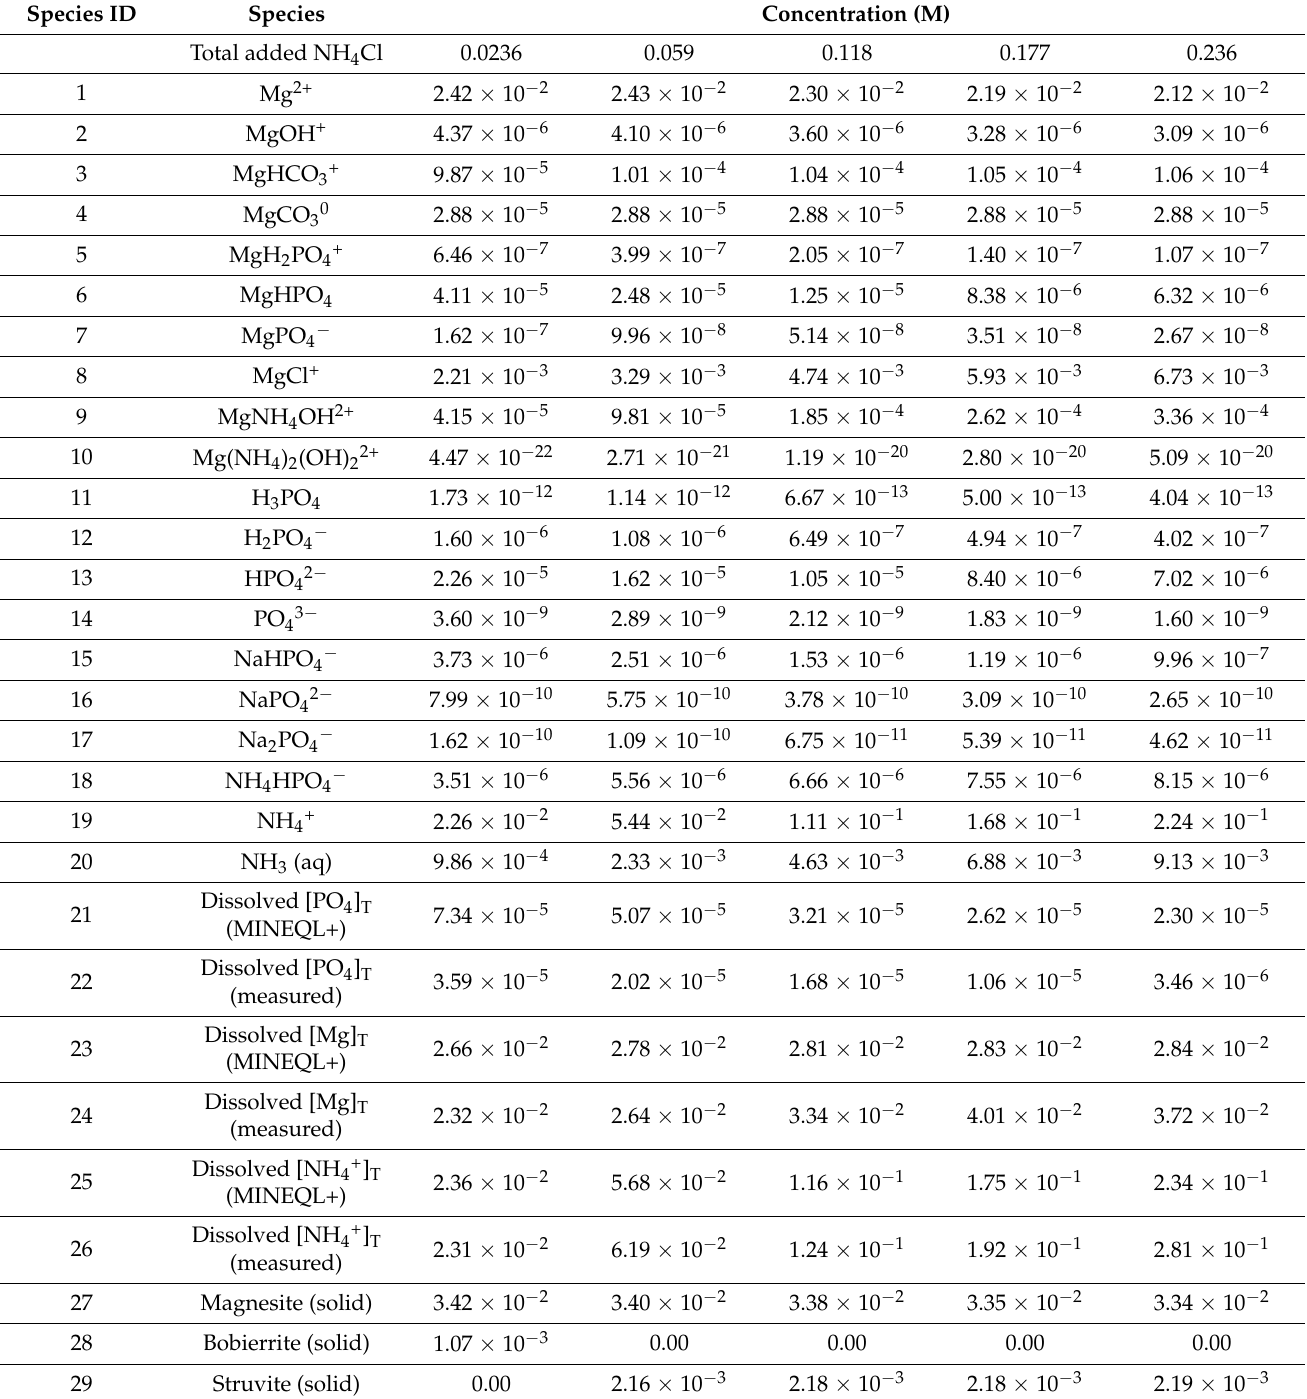
Table 1. Concentrations of dissolved and solid species for Mg char at pH 8 calculated using MINEQL+. Values for IDs 22, 24, and 26 were